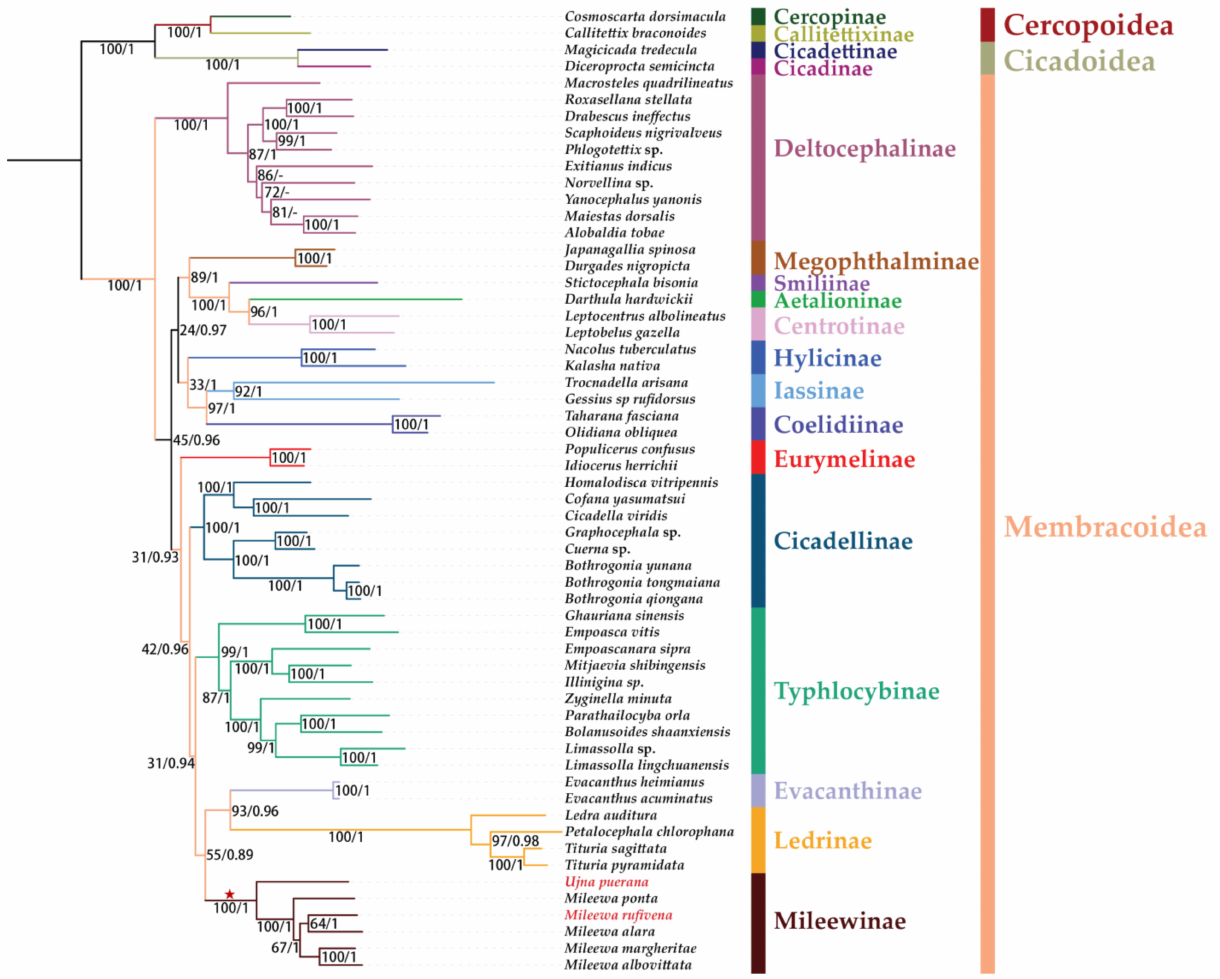
Figure 9. Phylogenetic tree inferred from the ML method based on PCG12 dataset and the BI method based on the AA dataset. Supports at nodes are bootstrap support values (BS) and posterior probabilities (PP). “-” indicates the clades or species are